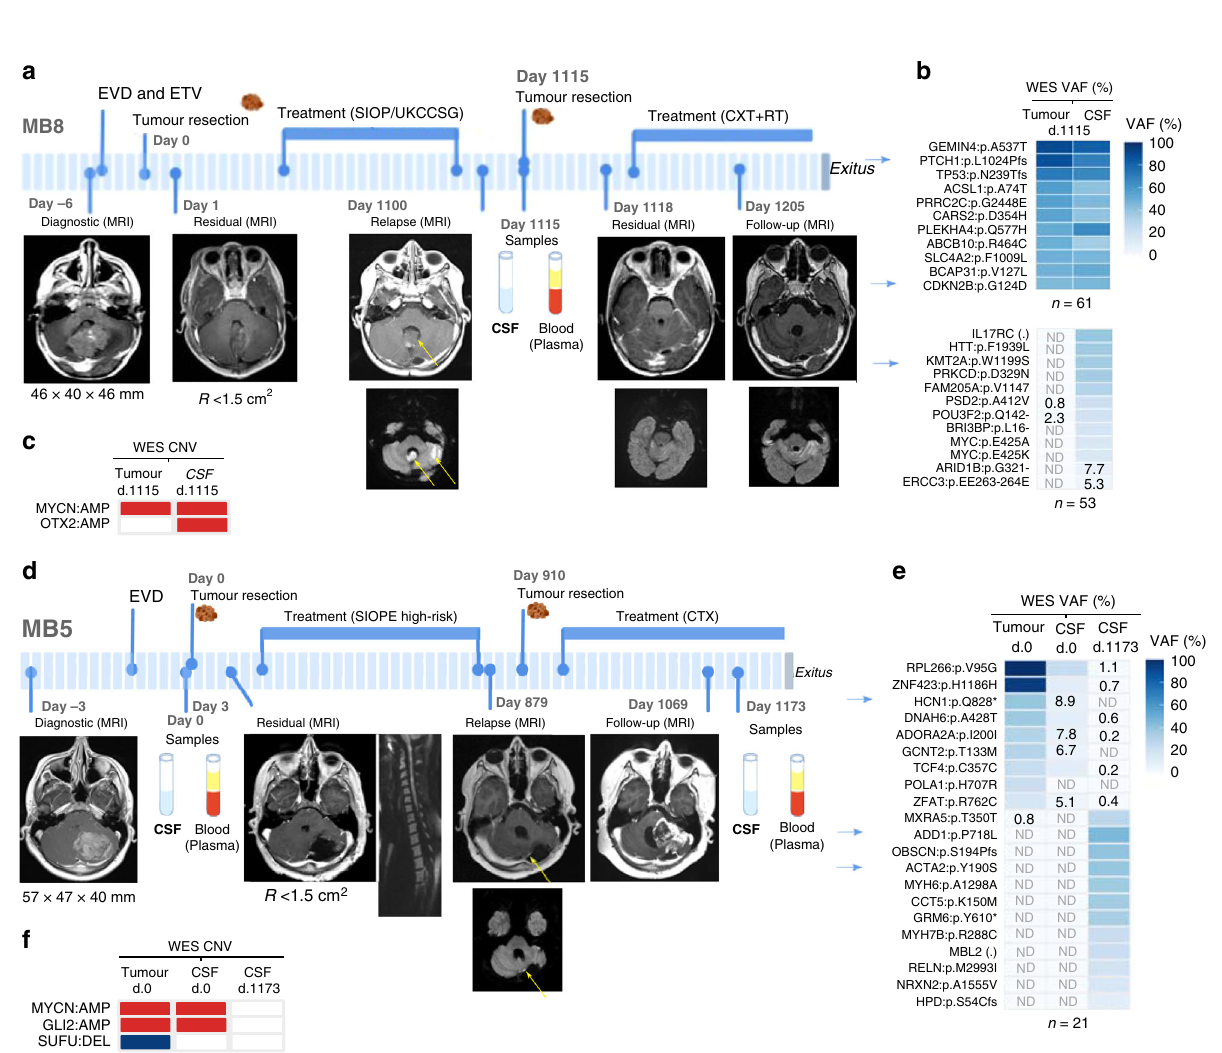
Fig. 5 CSF ctDNA reveals the evolving genomic landscape at relapse of patients with MB. Longitudinal monitoring of two paediatric patients with MB that relapsed and died from the disease: a – c MB8 and d – f MB5. a , d Clinical course indicating intervention for hydrocephalus, tumour surgery, treatment protocol, radiologic images (MRI), tumour size or residual disease, and patient samples obtained. Yellow arrows within the MRIs indicate the tumours at relapse. b , e Heatmap representing mutations and VAFs (%) identi fi ed from the WES of tumour DNA, CSF1 and CSF2 cfDNA samples. VAFs <10% were annotated. For patient MB8, a representative list of mutations (with a high/moderate impact or identi fi ed as drivers/predicted drivers by the Cancer Genome Interpreter) is shown. The fi rst heatmap is for mutations detected in both tumour and CSF ( n = 61) and the second one for private mutations ( n = 53). Blue arrows indicate the mutations selected for further validation. c , f Relevant MB CNV identi fi ed were indicated in red for ampli fi cation (log 2 > 1) or blue for deletion (log 2 < − 1). De fi nition of symbols and acronyms: not detected (ND), day (d), external ventricular drain (EVD), endoscopic third ventriculocisternostomy (ETV), residual (R) disease status: >1.5 cm 2 ( + ), <1.5 cm 2 ( − ), chemotherapy (CXT) and radiotherapy ampli fi cation, and partial loss of 17p (Fig. 5e, f and Fig. 3e). and were not detected at relapse for the HCN1 :p.Q828 * mutation Surprisingly, the analysis of CSF ctDNA at relapse revealed a detected in the primary tumour. In contrast, the levels of ctDNA genomic transformation, with a distinct molecular pro fi le not for alterations identi fi ed from the CSF during progressive disease shared with the primary nor with the fi rst relapsed tumour postrelapse were stable or increased throughout 81 days until the (Fig. 5e and Supplementary Fig. 2). Levels of ctDNA decreased patient died ( ADD1 :p.P718L VAF: 41.6-52% and ACTA2 :p.Y190S